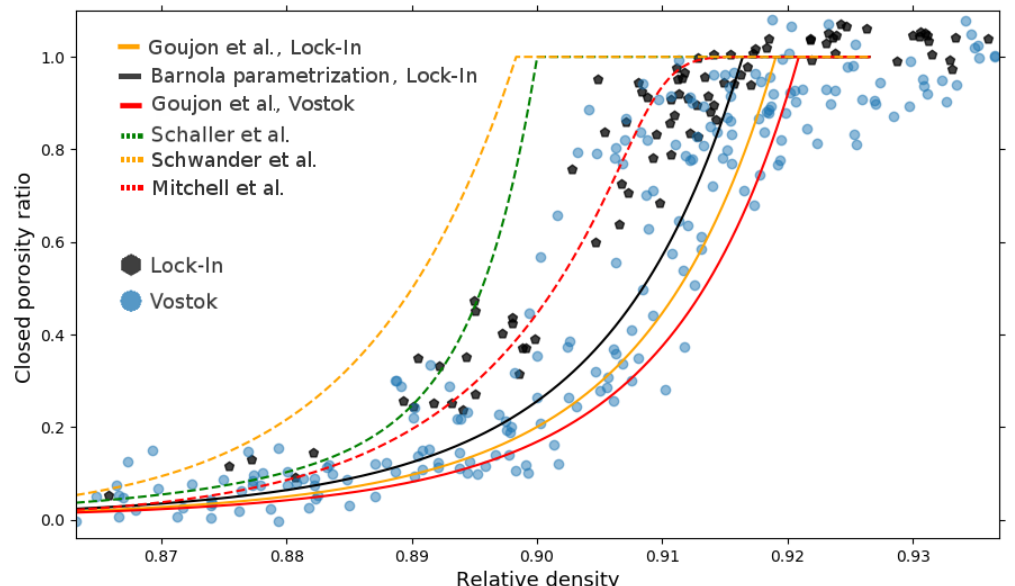
Figure 5. Comparison of closed porosity ratio data and parametrizations. The Lock-In closed porosity ratio obtained with pycnometry and tomography is displayed as black hexagons (this study). The closed porosity ratios measured by pycnometry in the Vostok firn are displayed as blue circles (data obtained by Jean-Marc Barnola, unpublished, see data availability section). The solid black curve is the Barnola parametrization for Lock-In, using V i = 0 . 114cm 3 g − 1 (derived from air content data). The orange and red solid curves are the Lock-In and Vostok parametrizations proposed by Goujon et al. (2003) using site temperatures as parameters. The dashed green curve is the parametrization proposed for the B53 site by Schaller et al. (2017). The dashed orange curve is the parametrization of Schwander (1989). The dashed red curve is the parametrization of Mitchell et al. (2015) adjusted to the Lock-In data.